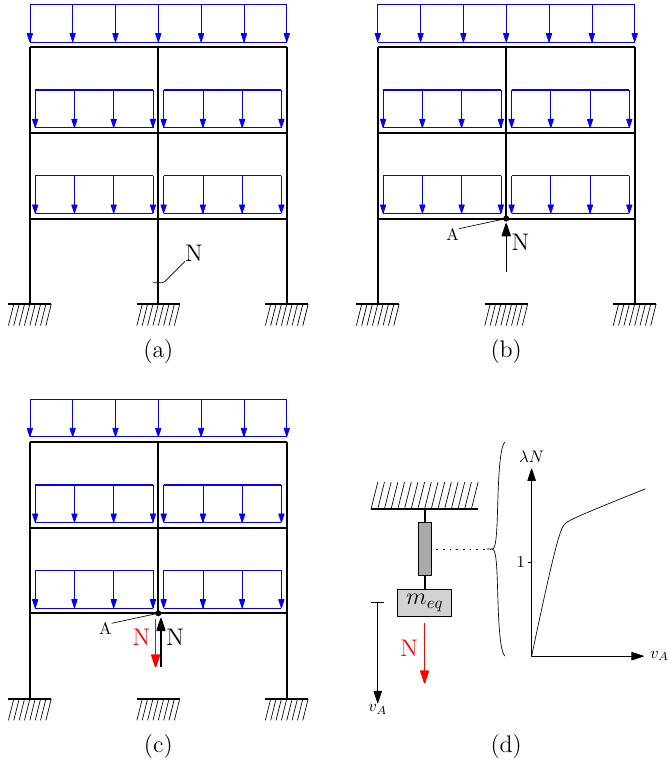
Figure 1. Scheme for the evaluation of the damage on a frame. The central bottom column is the removed element. ( a ) First, the internal forces in the element are evaluated. ( b ) Then, the element is removed and a nodal force, equal but opposite to the internal force is applied to the top